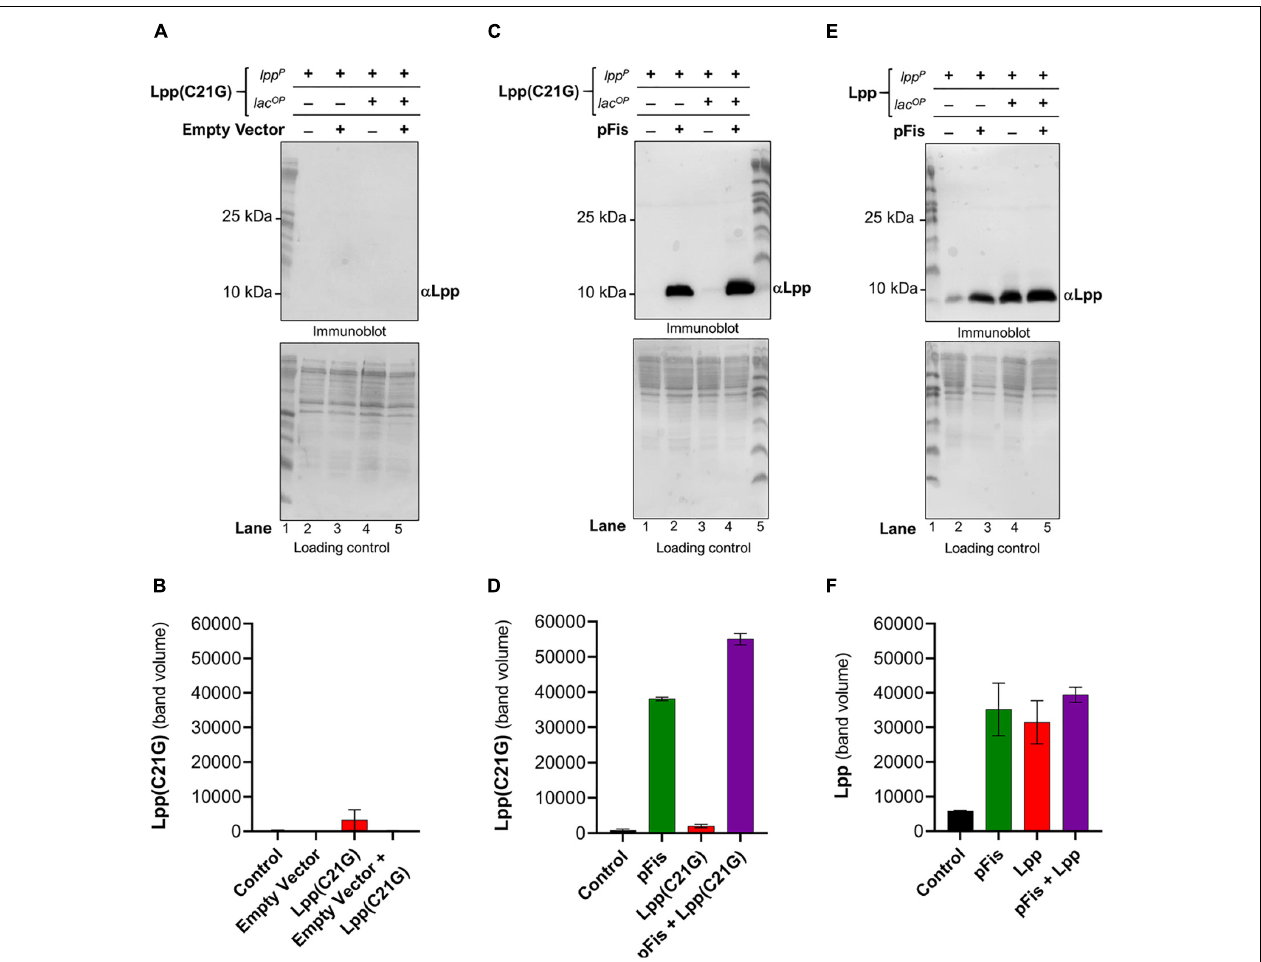
FIGURE 5 | Cells lacking fis reduces levels of Lpp(C21G) even when the inducer is present. (A,B) Immunoblotting of fis-null cells carrying an empty vector and a plasmid expressing Lpp(C21G) to detect Lpp(C21G) and quantitative analysis of Lpp(C21G) levels. (C,D) Immunoblotting of fis-null cells carrying plasmid expressing Fis (pFis) and Lpp(C21G) to detect Lpp(C21G) and quantitative analysis of Lpp(C21G) levels. (E,F) Immunoblotting of fis-null cells carrying plasmid expressing Fis (pFis) and Lpp to detect Lpp and quantitative analysis of Lpp levels. Lpp(C21G) and Lpp are expressed via Lpp ( lpp P ) and Lac ( lacUV5 OP ) promoters. All loading controls are ponceau-S staining for total protein normalization presented in grayscale. Data are means ± SEM of at least three independent